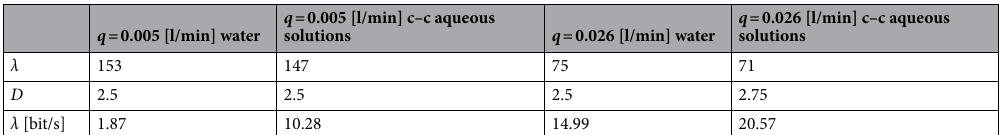
Table 3. Values of time delay, correlation dimension, and Lyapunov exponent calculated using data for the liquid penetration into the capillary at various air volume flow rates and for both water and c–c aqueous